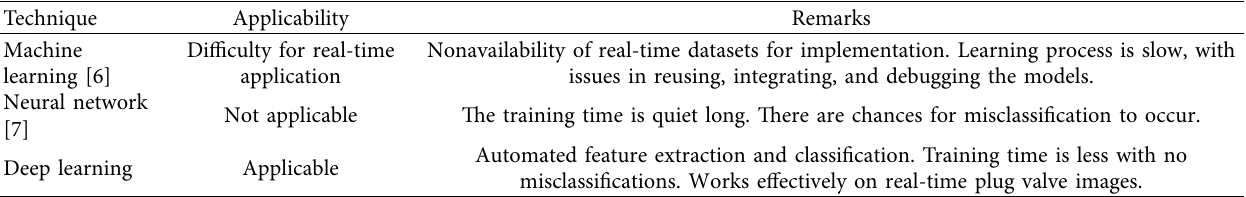
Table 1: Applicability and novelty of the proposed